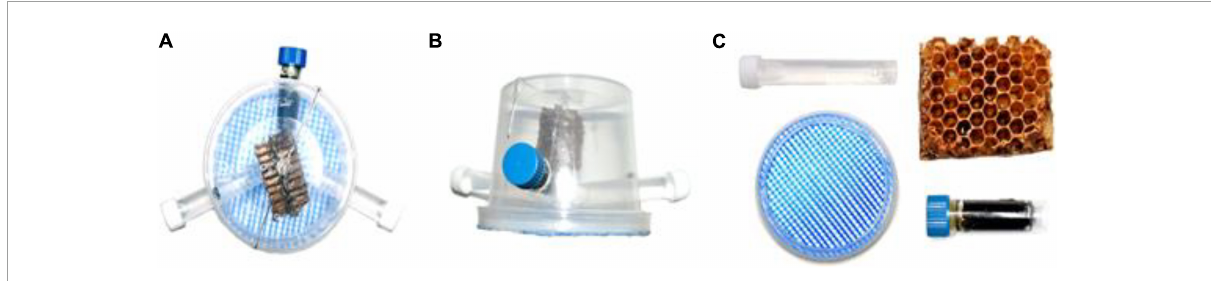
FIGURE1 Experimental cage (A) from the top, (B) from the front, and (C) ingredients (two 10-ml tubes for water and 50% sucrose solution, Ø 120 × h 80-mm breeding cage with mesh can ventilate, 5-ml tube for dough patty, 5 × 5-cm frame piece to relax honey